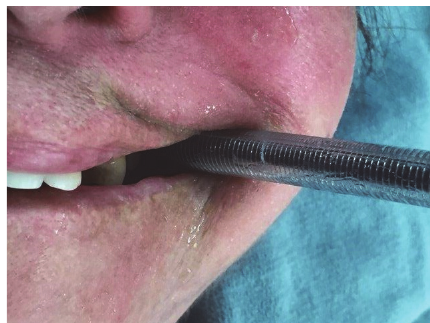
Figure 2: Postretromolar intubation showing tracheal tube in con- tact only with the last